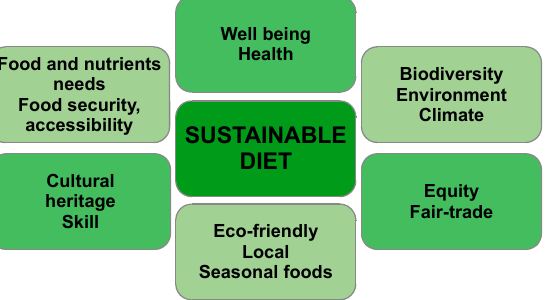
Figure 6. Key elements of a sustainable diet—authors’ adaptation of data from [53].